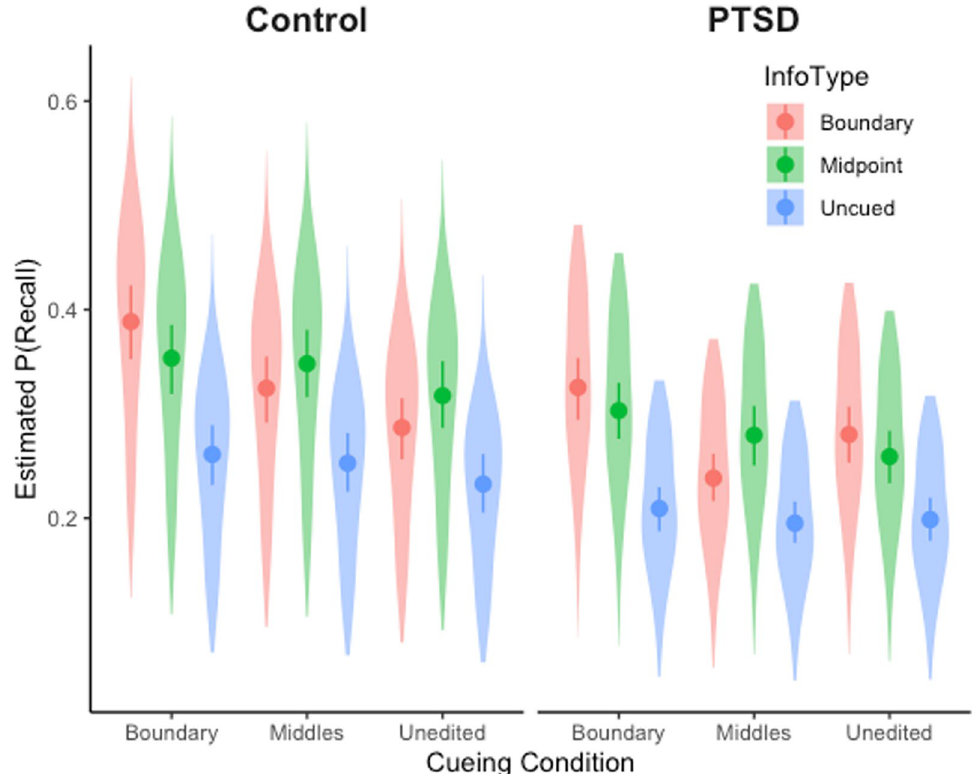
Fig. 2 Recall probability as a function of group, cueing condition, and information type. Points represent means and whiskers show 95% confidence